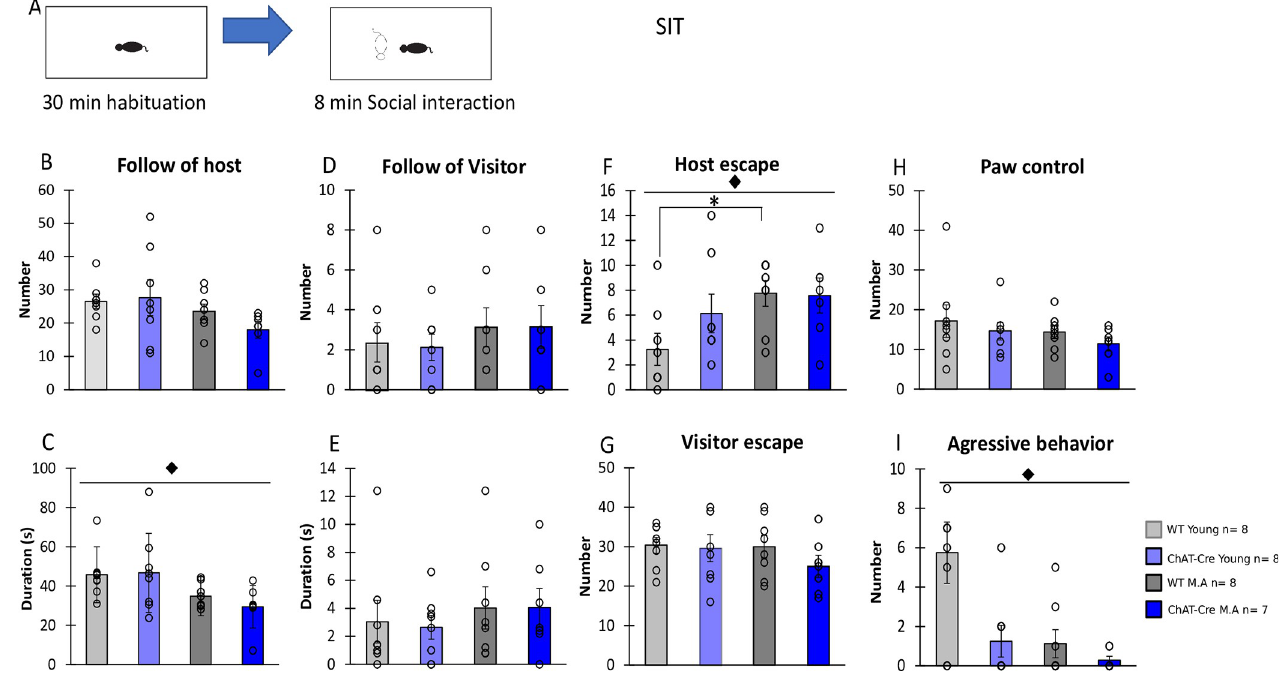
Fig 3. Behavior in the Social Interaction Task. A) Schematic representation of the social interaction task procedure. B) Number of follow episodes made by Host mice. C) Duration of follow episodes (i.e., following while making oro-genital contact) made by Host mice. D) Number of follow episodes made by Visitor mice. E) Duration of follow episodes made by Visitor mice. F) Number of escape (i.e., interuption of contact) episodes made by Host mice. G) Number of escape episodes made by Visitor mice H) Number of paw control made by Host mice (i.e., number of times Host mice put their forepaws on the head or back of Visitor mice). I) Number of aggressive episodes of Host mice. WT young n = 8, ChAT-Cre young n = 8, WT Middle Age n = 8, ChAT-Cre Middle Age n = 7. Visitor mice (young n = 6 and middle age n = 6). Data are presented as means ± SE; � p < 0.05; �� p < 0.01; ��� p < 0.001; Kruskal-Wallis rank-sum test analysis then Wilcoxon and d signed-rank tests were applied when appropriate. # represents the genotype effect and ◆ the age effect. Kruskal-Wallis results were not represented for simplicity.